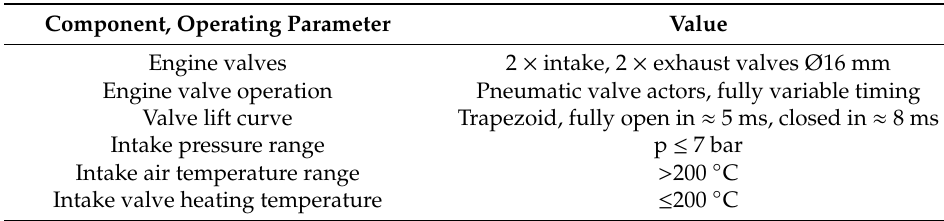
Table 3. Air supply and gas exchange valve